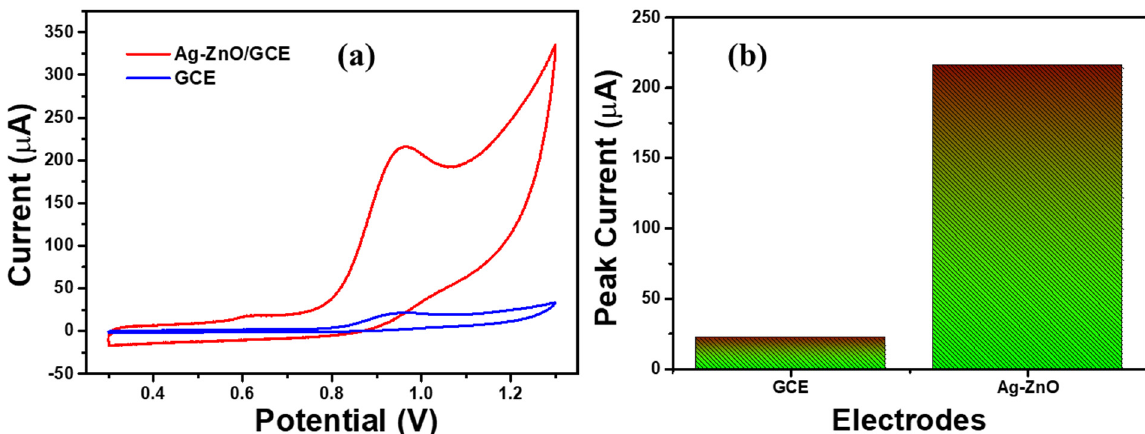
Figure 7. ( a ) CV responses of bare GCE and Ag-ZnO/GCE ( b ) 4-NP sensing activity of the bare GCE and Ag-ZnO/GCE electrode with presence of 500 µM 4-NP containing 0.1 M PBS (pH = 7) solution. (Accumulation time: 2 min, catalyst loading volume: 10 µL).